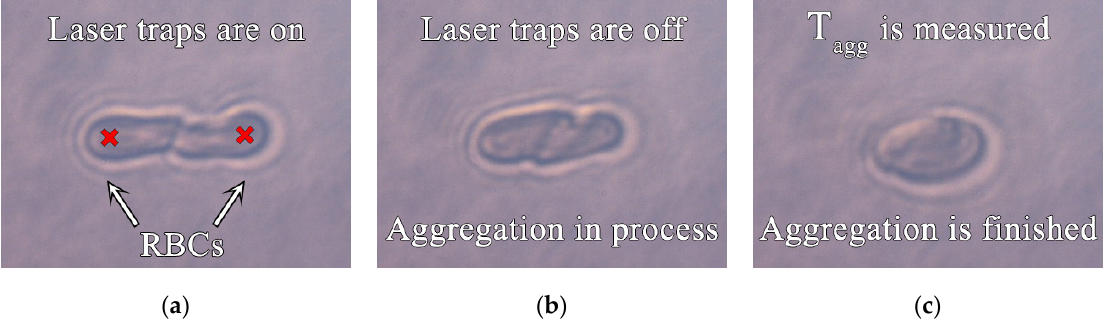
Figure 2. Three steps of T agg measurement. Red crosses indicate the laser traps. ( a ) Two separate RBCs are brought together until the state of a “point contact”; ( b , c ) RBCs start to aggregate (overlap) after the laser beams are shut off.